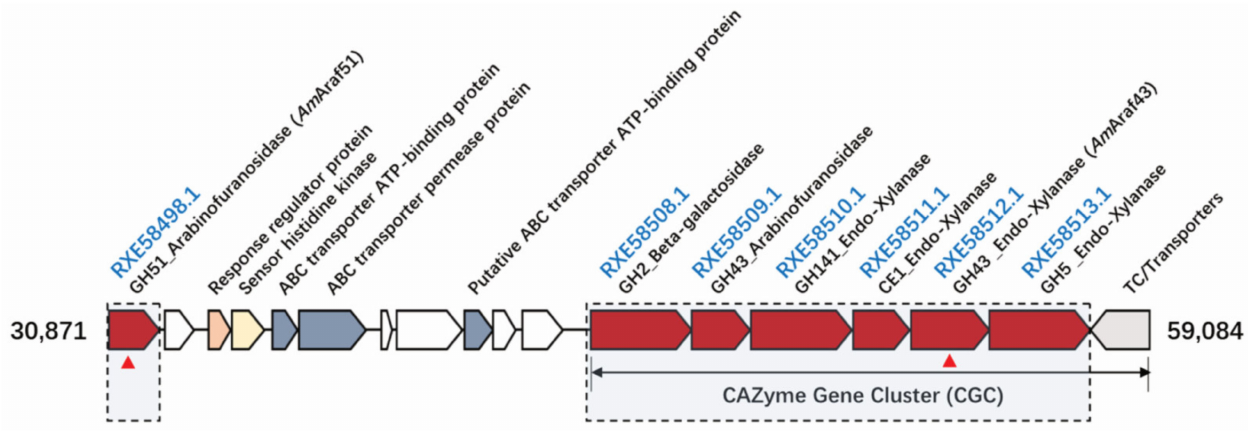
Figure 1. Gene organization of the putative CAZyme gene cluster on the genome of A. mesophilus N2K1 (functional annotation was performed by the dbcan database and Prokka Genome Annotation). The genes characterized in this study are marked with red